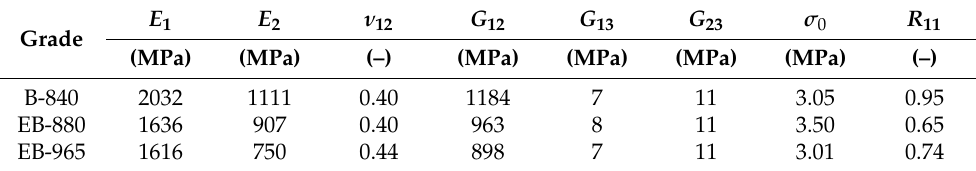
Table 2. Material data used in the constitutive models of corrugated boards considered